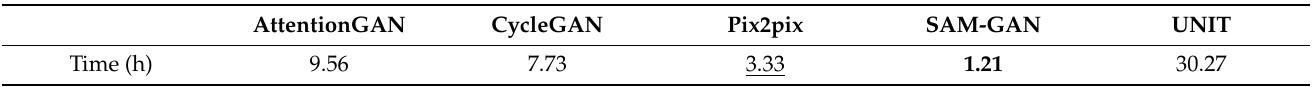
Table 2. Training time required for the baseline and SAM-GAN models ( K = 1). (Bold: performance first; underlined: performance